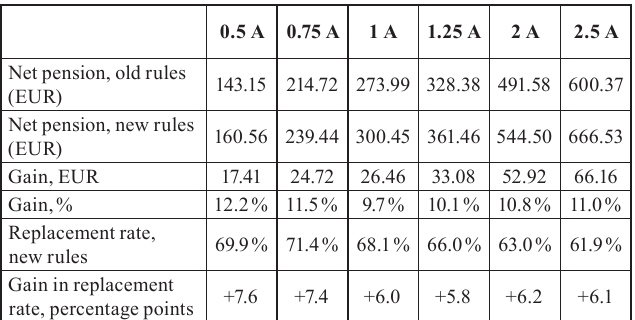
Theoretical Pensions and Replacement Rules in Accordance with Revised Valorisation